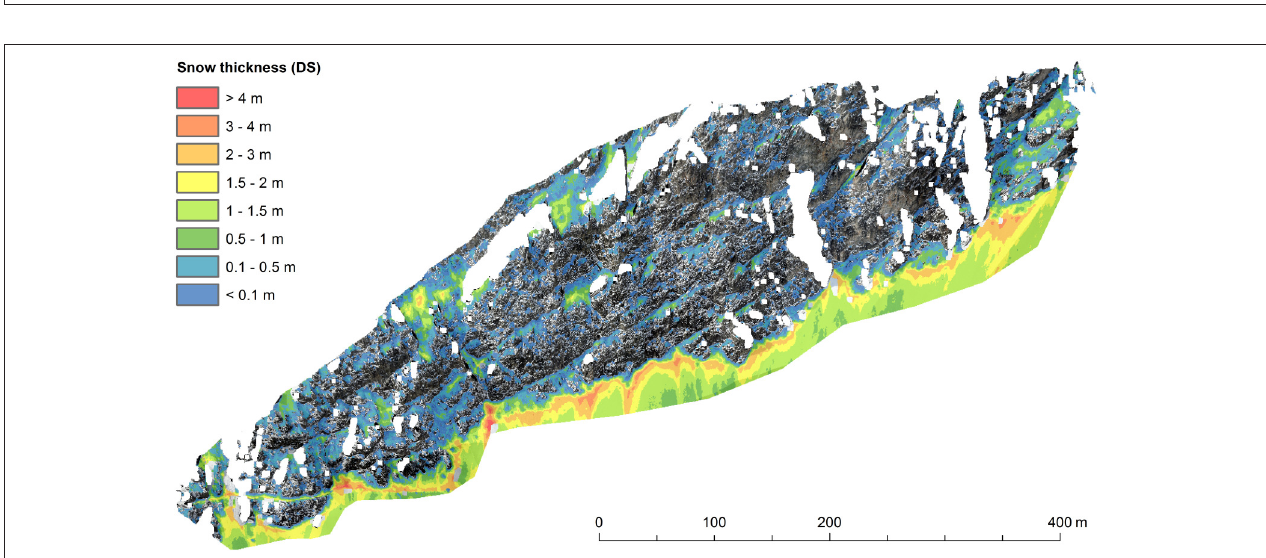
FIGURE 6 | Spatial distribution of snow thickness on 25 March. Most snow lay at the top of the “slope toe.” The spatial patterns of DS were very similar to those of 1 DS. The orientation of the rock face is similar to the view in Figure 1B .